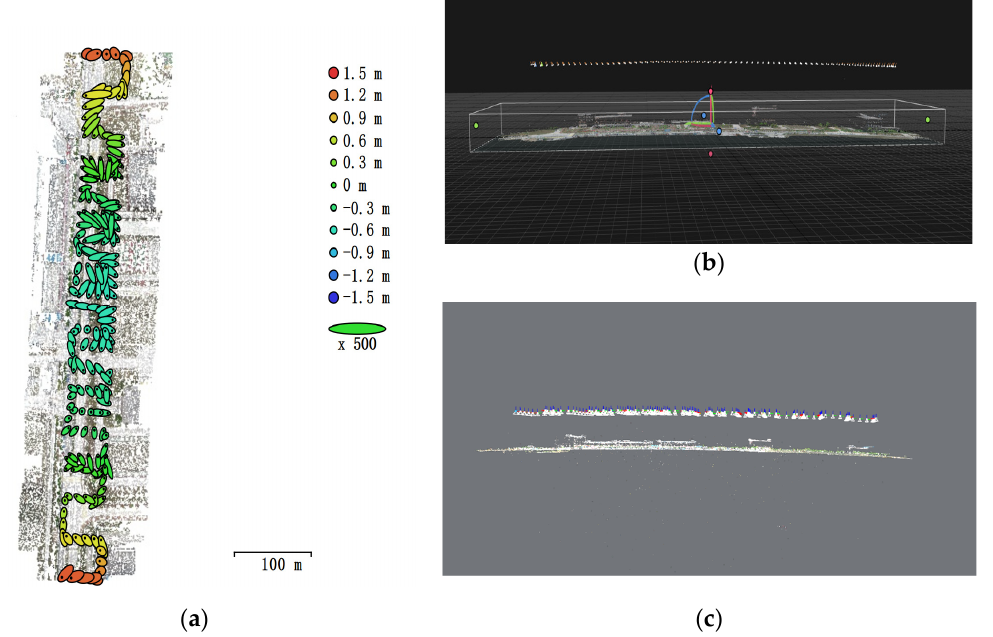
Figure 1. The “bowl effect” of self-calibration BA for long corridor UAV images. ( a ) The result of commercial software AgiSoft Photoscan V1.4.1, Z error is represented by the ellipse color, and X, Y errors are represented by the ellipse shape. ( b ) The result of commercial software Reality Capture V1.2, and ( c ) the result of open-source software AliceVision.